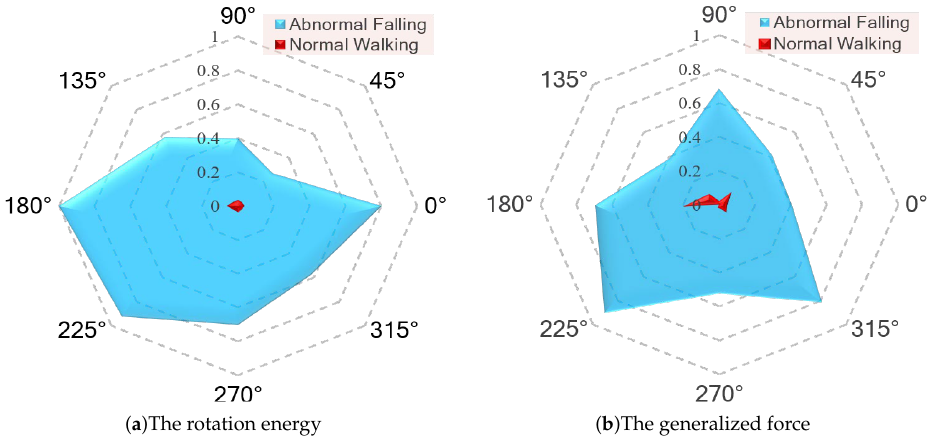
Figure 9. The radar charts of the characteristics in eight directional falling and walking samples.